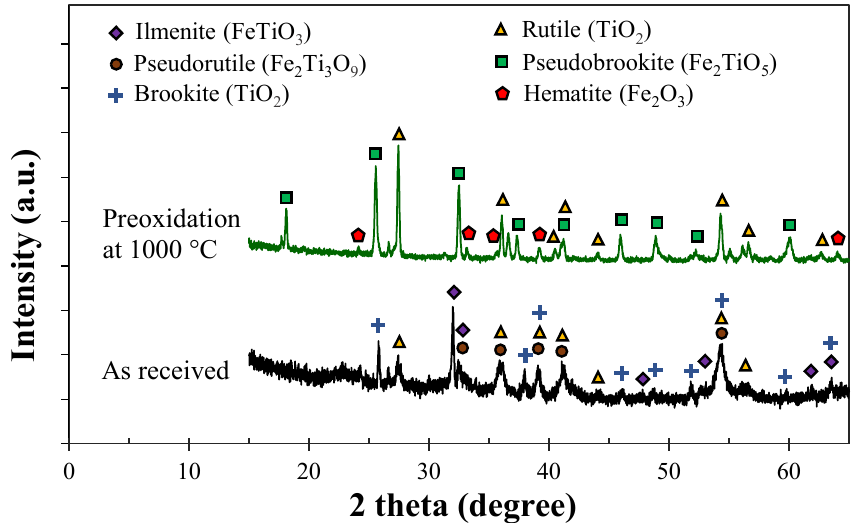
Figure 2. XRD spectra of ilmenite concentrate before and after pre-oxidation.